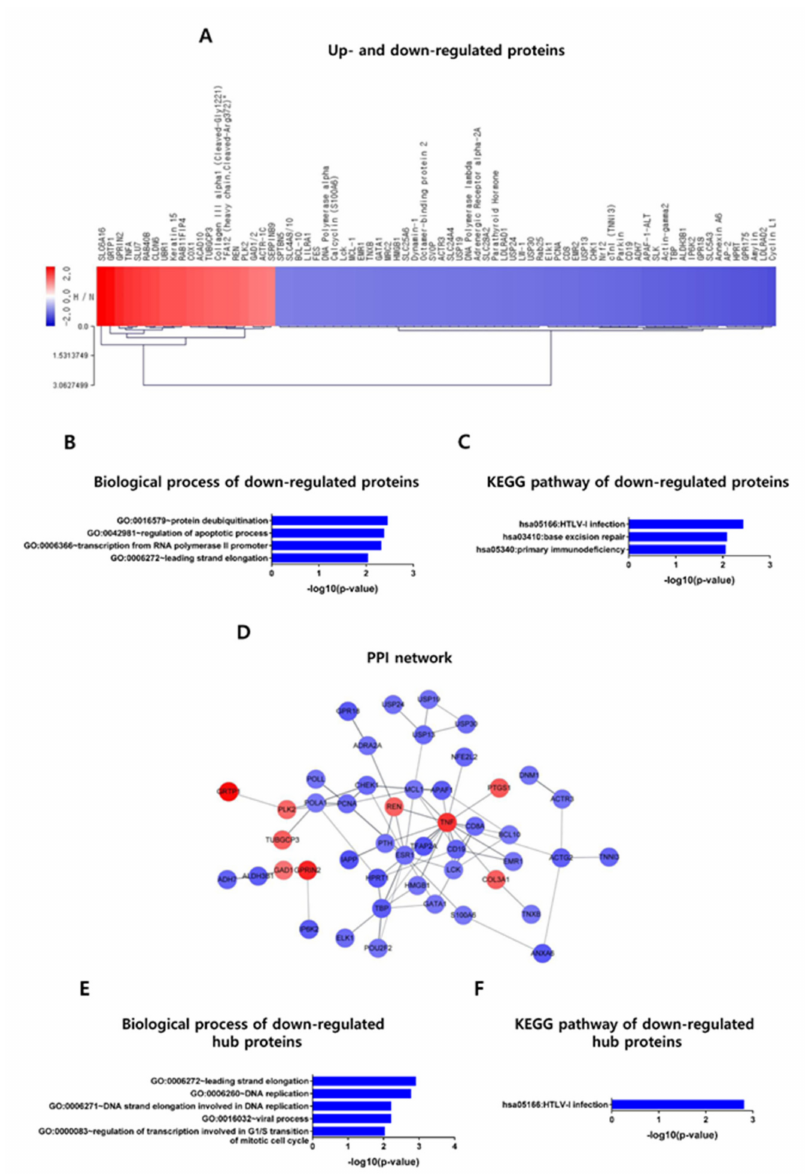
Figure 4. Profiling of intracellular signaling and the selection of hub proteins in HeLa cells treated with H-CM or N-CM. Intracellular proteins up- (red) and down-regulated (blue) (>2-fold) [34] in HeLa cells treated with H-CM compared with N-CM, as identified by a protein antibody array analysis ( A ). Biological process terms from the GO analysis of proteins down-regulated in HeLa cells treated with H-CM compared with N-CM ( B ). The KEGG pathway analysis [35] of proteins down-regulated in HeLa cells treated with H-CM compared with N-CM ( C ). PPI network [36,37] of intracellular proteins up- and down-regulated in HeLa cells treated with H-CM compared with N-CM ( D ). The biological process terms from the GO analysis of hub proteins down-regulated in HeLa cells treated with H-CM compared with N-CM ( E ). The KEGG pathway [35] analysis of hub